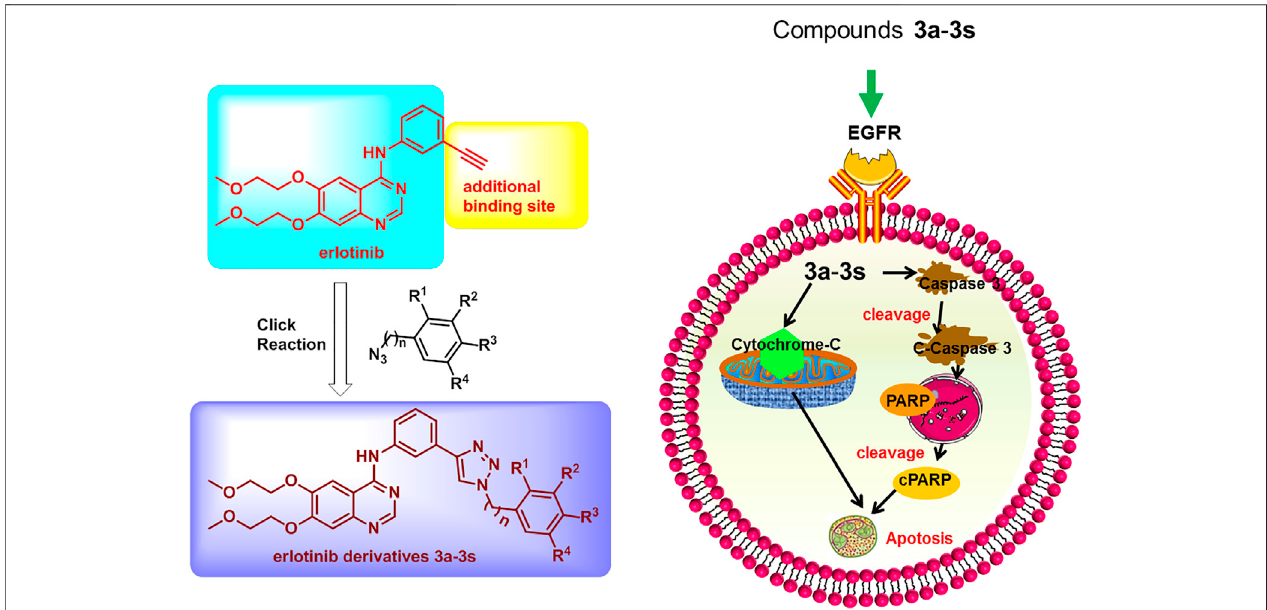
FIGURE 2 | Design strategy of erlotinib